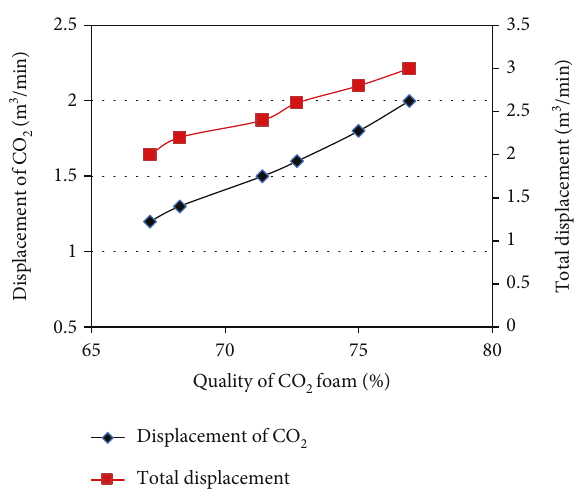
Figure 1: Pump rate and CO